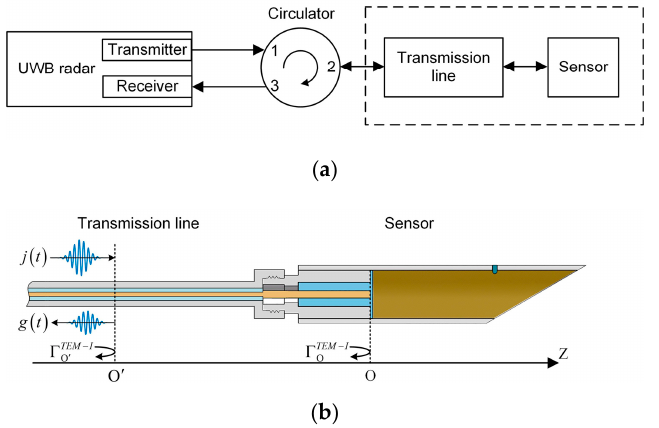
Figure 6. Diagram of reflection coefficient measuring approach: ( a ), block diagram; ( b ), detailed structure in the dashed line box.